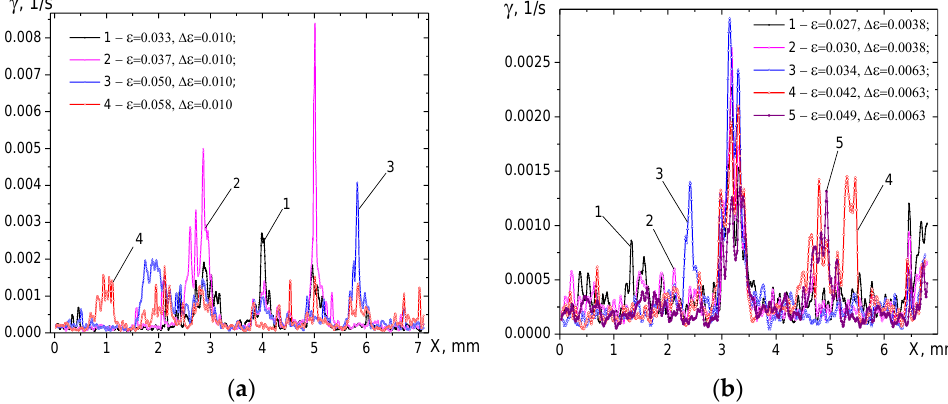
Figure 10. Spatial distribution of CPS rate  (x, y = Y m /2), measured along the midline of Specimen #1 ( a ) and Specimen #4 ( b ) at the deformation Stage II. #1 ( a ) and Specimen #4 ( b ) at the deformation Stage